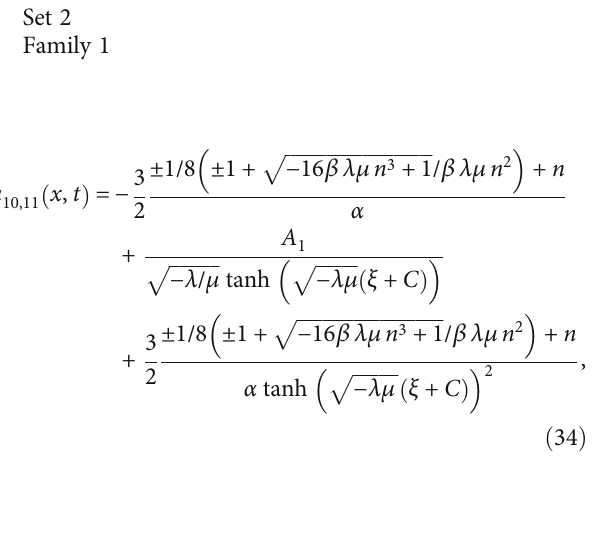
Figure 11: Dynamical behavior of function solution of u